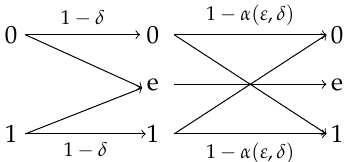
Figure 5. Optimal privacy filter for P Y | X = BEC ( δ ) where δ ( ε , α ) is specified in